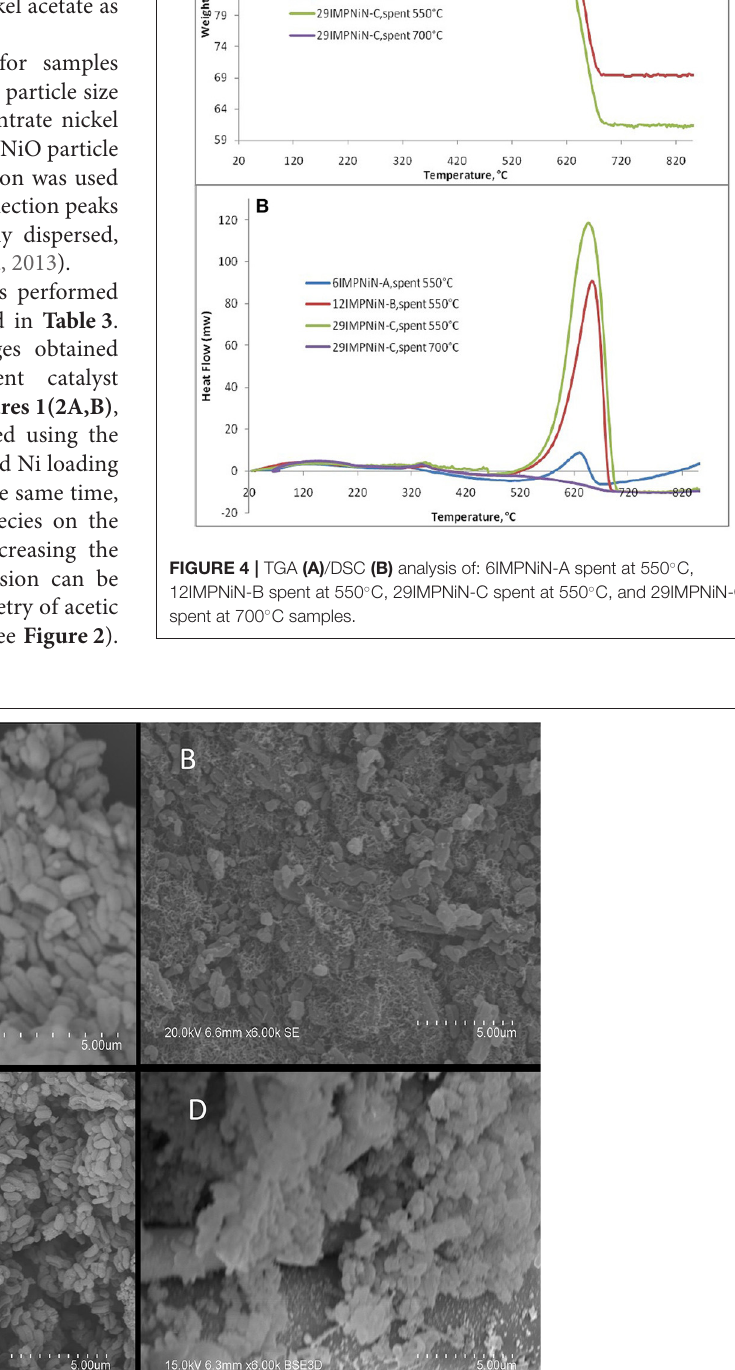
Frontiers in Chemical Engineering |